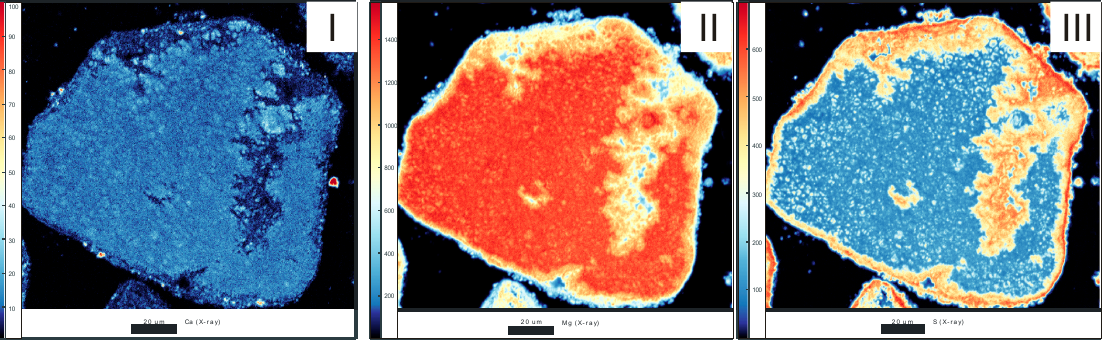
Figure 7. Sample of magnesite from Wiry after the sulfation process. Distribution maps of Ca ( I ), Mg ( II ) and S ( III ) in the cross section of the sorbent grain (EMPA).